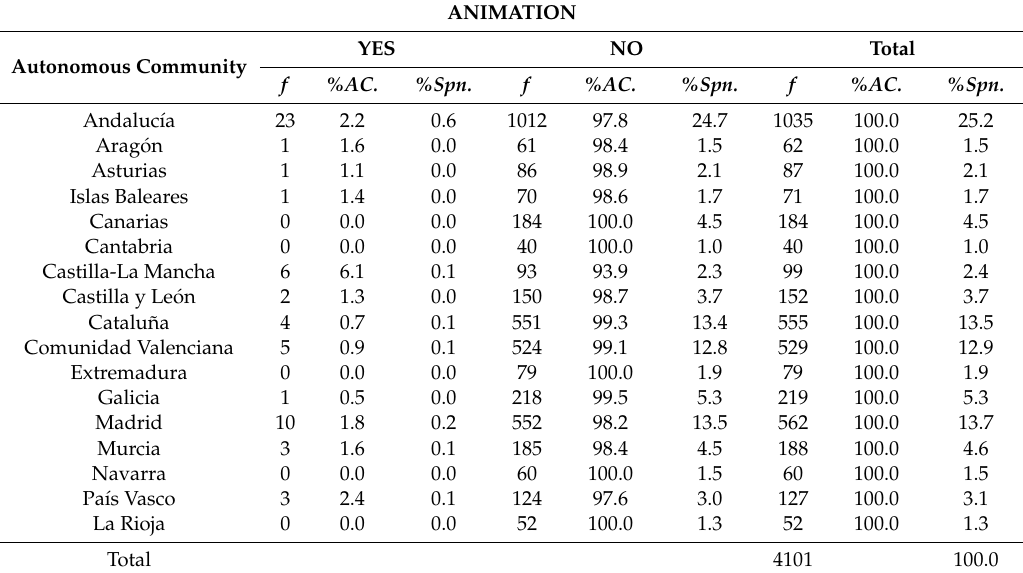
Table 6. Percentages and frequencies of animation films seen by teacher (cid:48) s degree students, according to the Autonomous